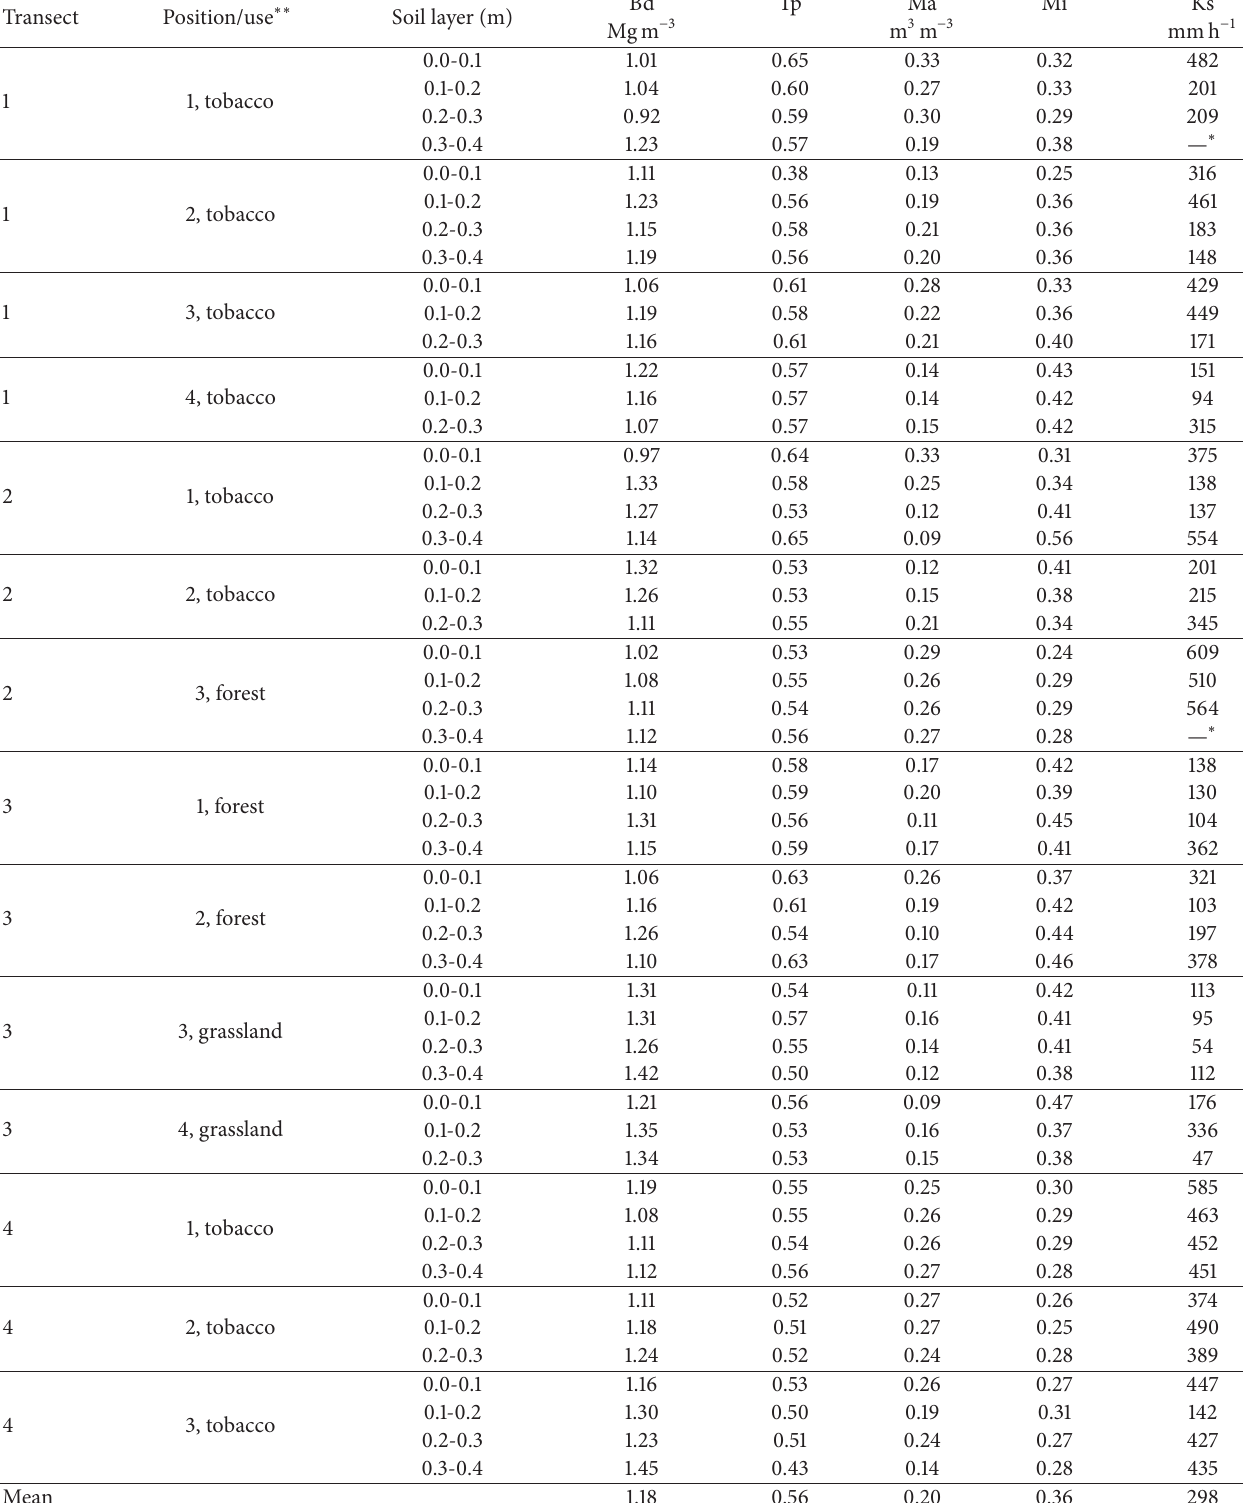
Table 2: Bulk density (Bd), total porosity (Tp), macroporosity (Ma), microporosity (Mi), and saturated hydraulic conductivity (Ks) of soil for five transects and different points in the